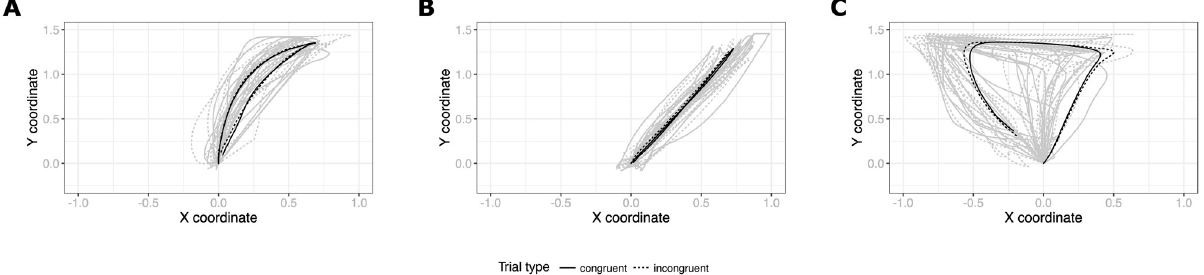
Fig 4. Example passive trajectories of 3 different participants in Experiment 2. Shown in black are average trajectories from the whole experiment duration. Shown in gray are particular trajectories from the last 40 trials. One can note that participants differ in how they go towards the response box—in a slightly curved manner (A) or in a straight line (B and C). They also differ in how they choose to return to the starting position—curved but staying in the same half of the screen (A), in a straight line (B) or making a circle through the opposite part of the screen (C).